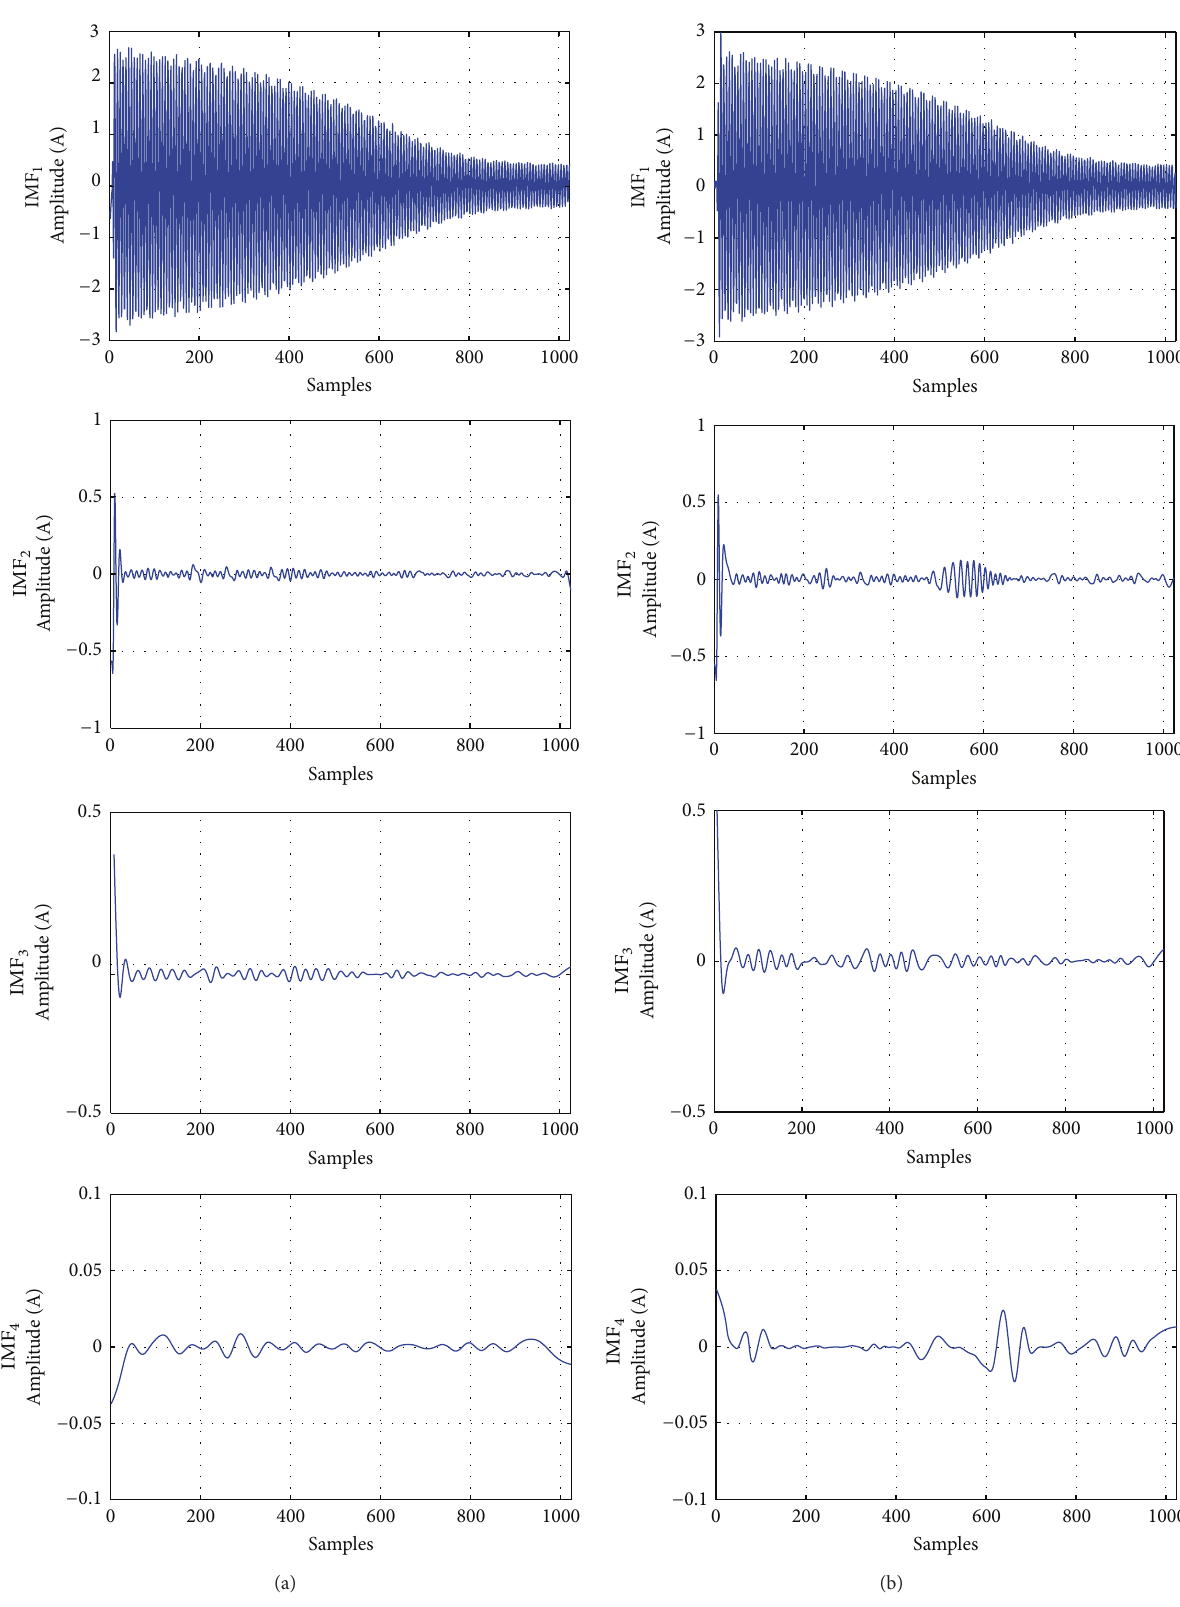
Figure 16: Resulting IMFs of the EMD hardware implementation: (a) healthy motor and (b) faulty motor with two broken rotor